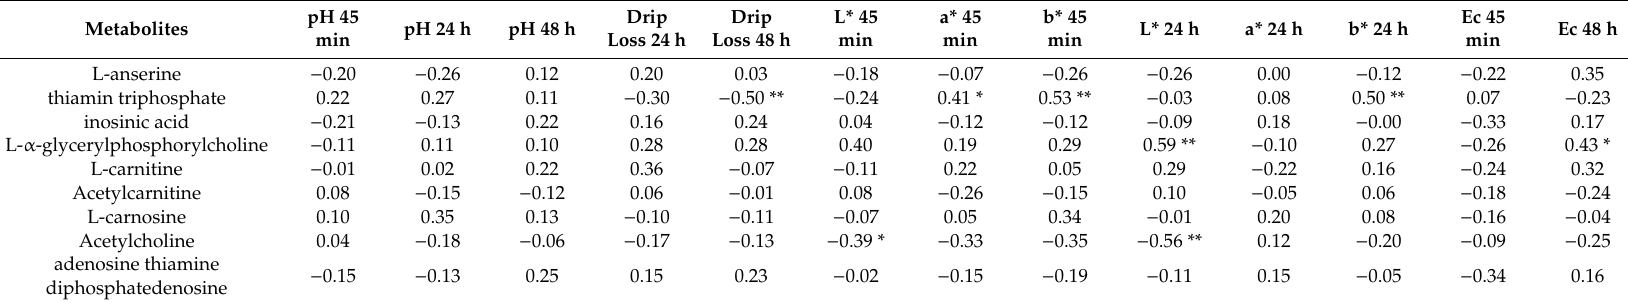
Table 2. Correlation among metabolites content, pH, drip loss, meat color, and electrical conductivity of longissimus dorsi muscle in finishing pigs (Pearson’s linear regression test, n = 24).